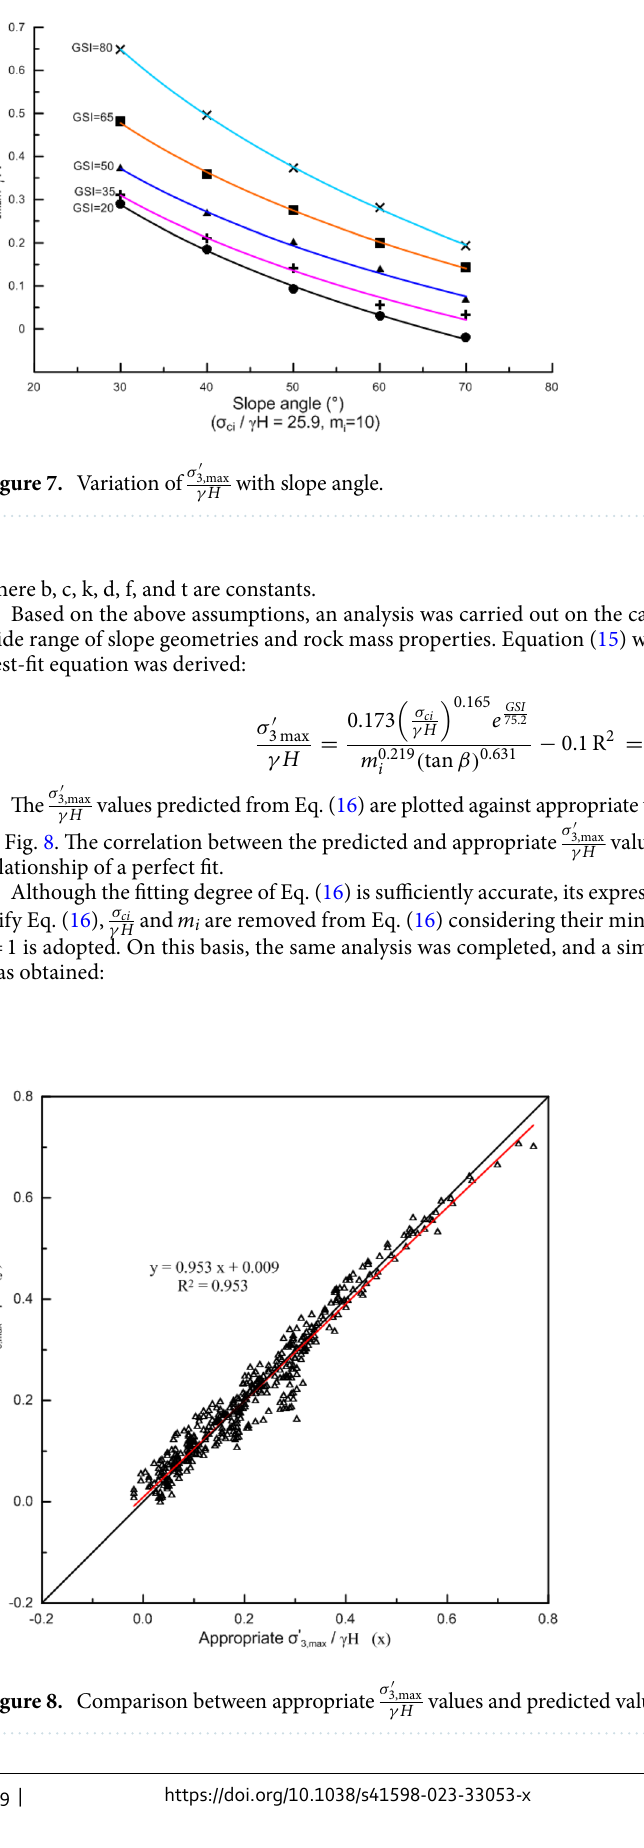
Figure 8. Comparison between appropriate